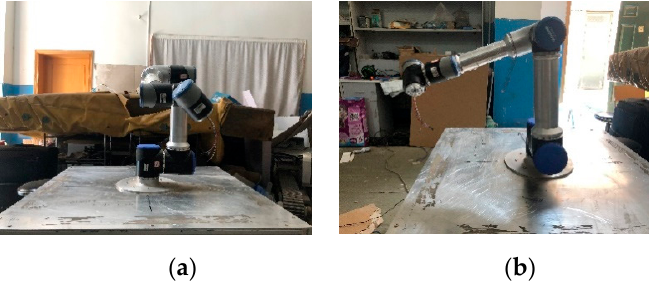
Figure 17. ( a ) Posture of the robot after completion of its run from the front. ( b ) Posture of the robot after completion of its run from the side.